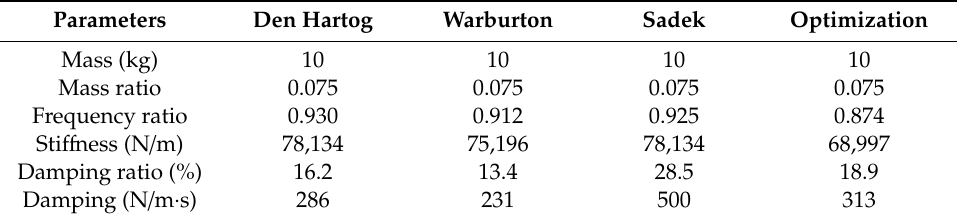
Table 5. Properties of TMDs designed while using optimum methods.